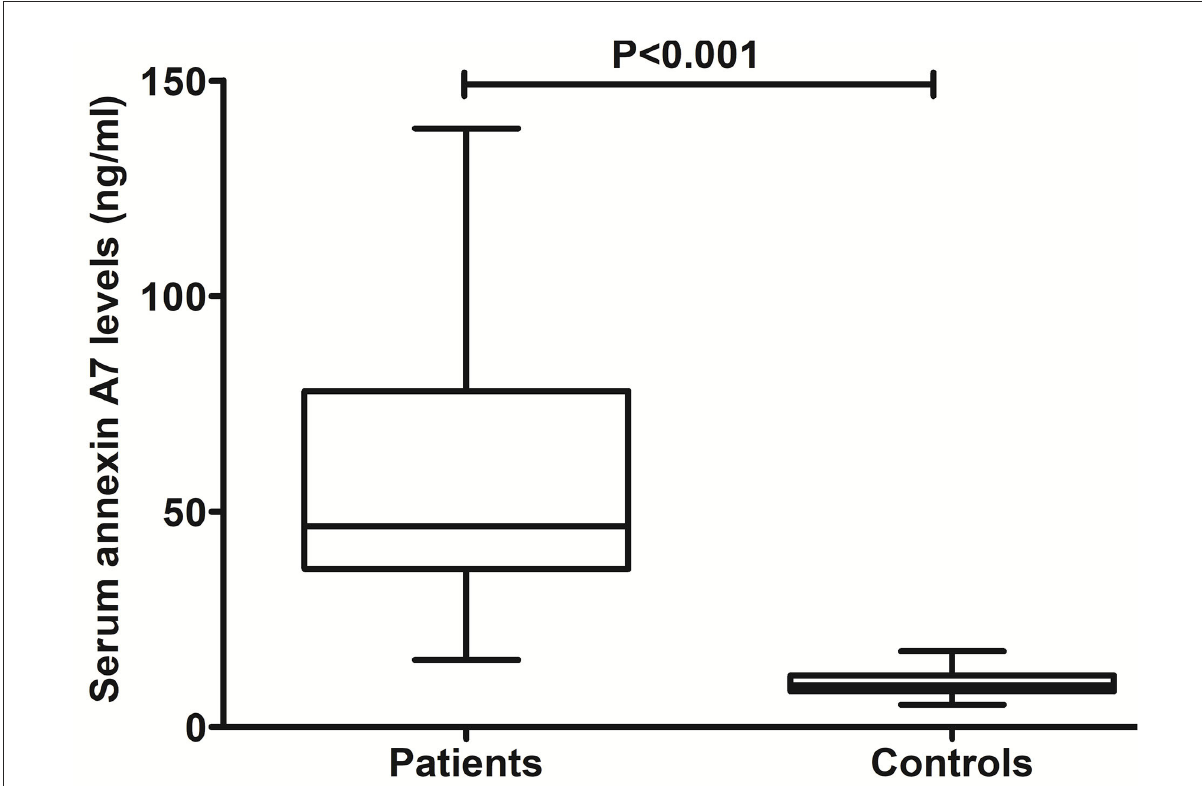
FIGURE2 Change of serum annexin A7 levels after spontaneous intracerebral hemorrhage. There was a substantial enhancement in serum annexin A7 levels of patients with intracerebral hemorrhage relative to healthy controls using the Mann–Whitney U test ( P <